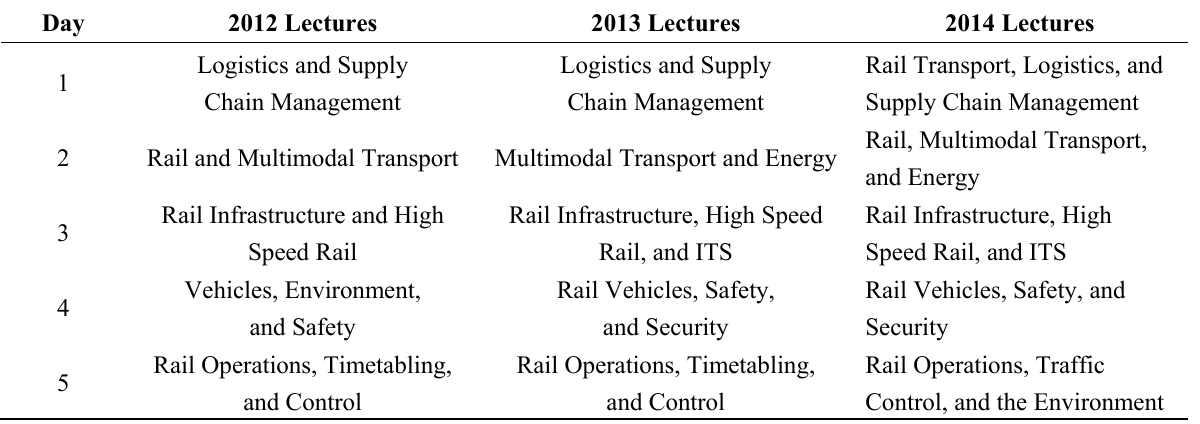
Table 2. Thematic areas of lectures delivered in Week One of the